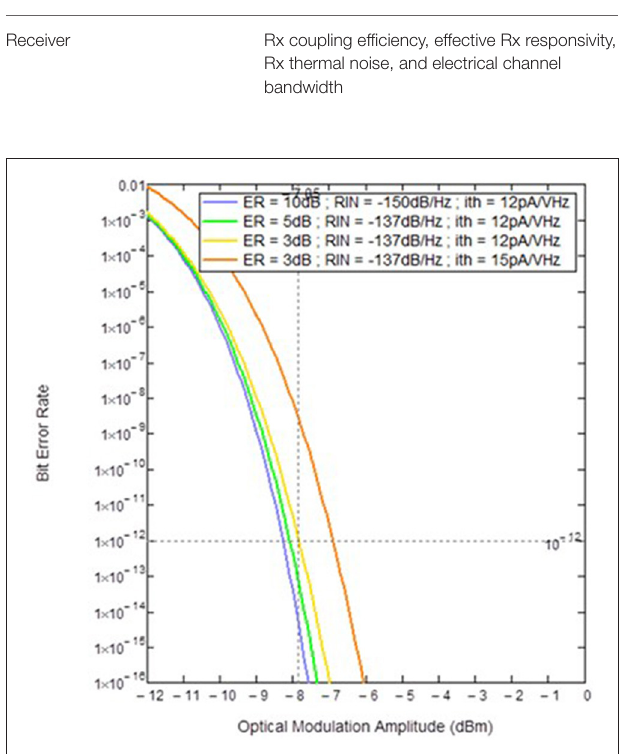
FIGURE 2 | Estimated BER performance of an on-off keying 25 Gb/s transmission for different values of ER, RIN, and thermal noise density (effective Rx responsivity = 0.14